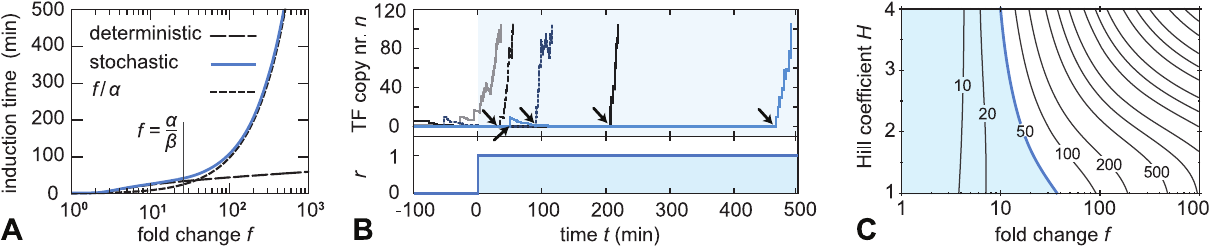
Figure 4. Auto-activation strongly affects the time required for induction. Fig. A: The induction time (defined in the main text) as a function of fold change f , for the case H ~ 1 (no cooperativity). In the deterministic model, the induction time depends only mildly on f . However, at large f the stochastic model deviates strongly from the deterministic one and predicts a dramatic slowdown. The slowdown sets in when the steady state distribution becomes bimodal, that is, when f w a = b ; then, the induction becomes limited by the first transcription events, occurring at approximately the basal rate a = f . Fig. B: Typical time traces for the induction process, obtained by kinetic Monte Carlo simulations, at f ~ 150 . The waiting time for the first transcription event (indicated with arrows) is indeed rate-limiting. Fig. C: Contour plot of the induction time in the stochastic model (in minutes). At f ~ 1 the auto-activation is removed and the induction is instantaneous. If we arbitrarily require that the response time is at most 50 minutes, only the shaded region is adequate. Parameters: a ~ 1 min { 1 , b ~ 0 : 04 min { 1 , b ~ 10 , K ~ 50 = V